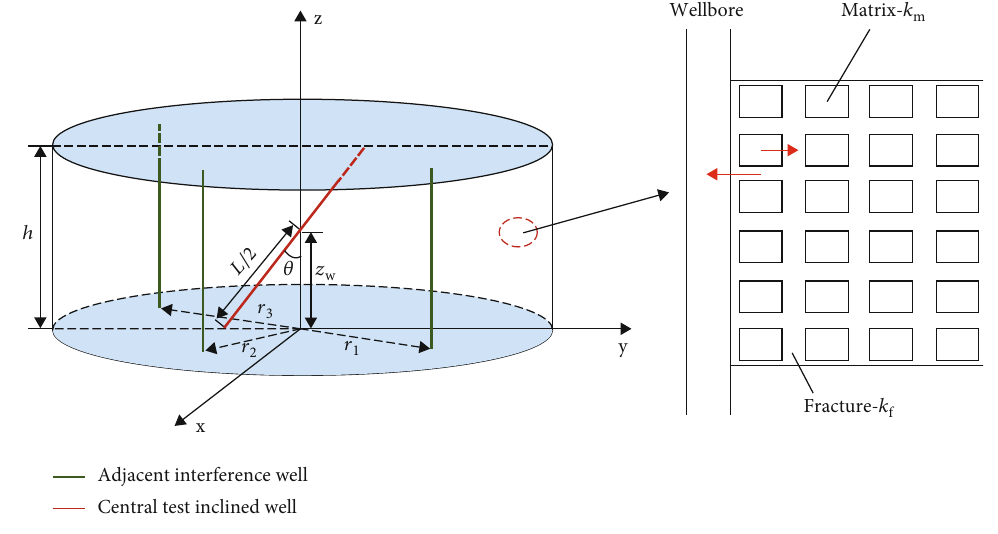
Figure 3: Physical model